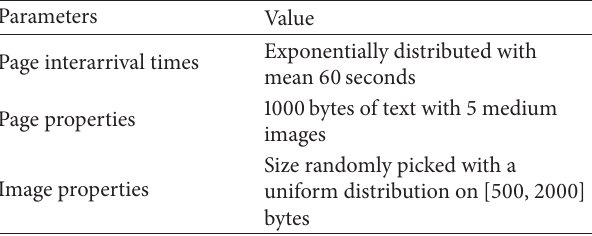
Table 5: The traffic model for HTTP application.